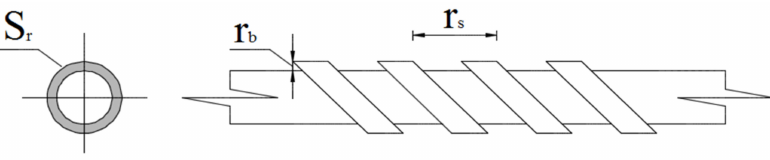
Figure 15. Definition of the area to space ratio ( a s ). Adapted by